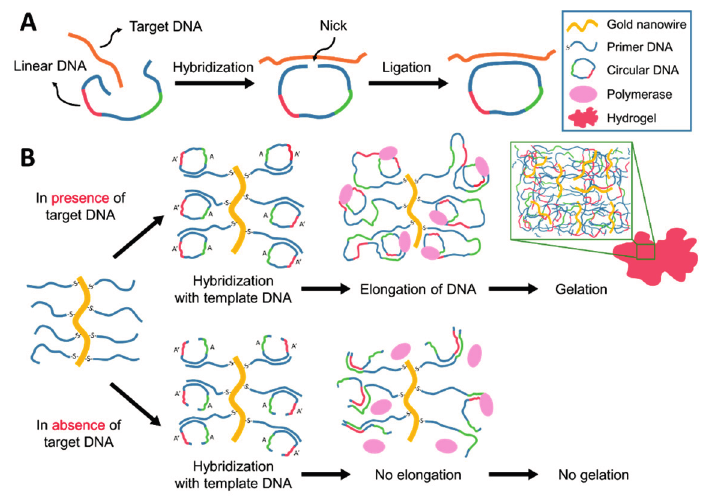
Figure 1. Schematic illustration of the label-free detection of single-stranded DNA. ( A ) Scheme of circular DNA preparation in the presence of target DNA; and ( B ) scheme of hydrogel synthesis with the prepared circular DNA. S indicates thiol group. Sequence of A and A ʹ are complementary.